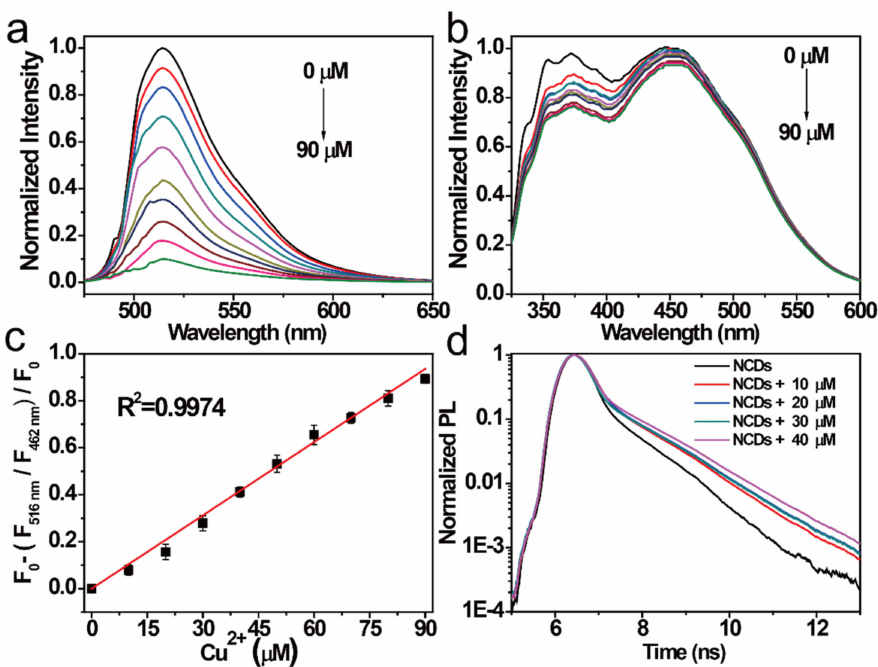
Figure 5. FI of the NCDs excited by ( a ) 497 nm radiation and ( b ) 311 nm radiation after the addi- tion of different Cu 2+ concentrations (from top to bottom: 0–90 µ M). ( c ) Relationship between the F 515nm /F 454 nm ratio versus the Cu 2+ concentrations (0–90 µ M). ( d ) Decay PL spectra of the NCDs quenched by Cu 2+ at different